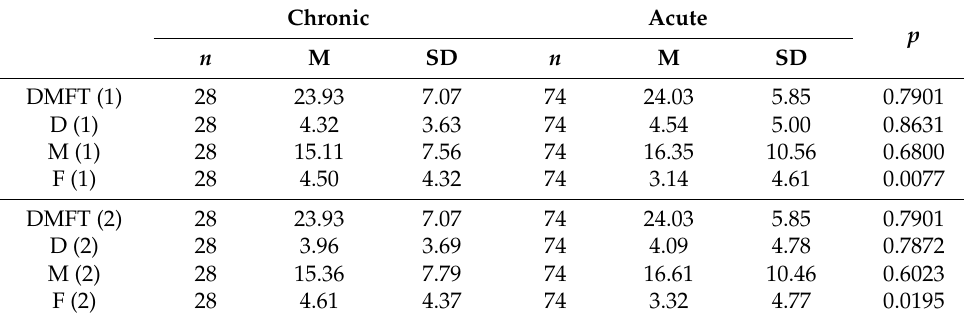
Table 10. Leukemia type and DMFT index before (1) and after (2) chemotherapy.